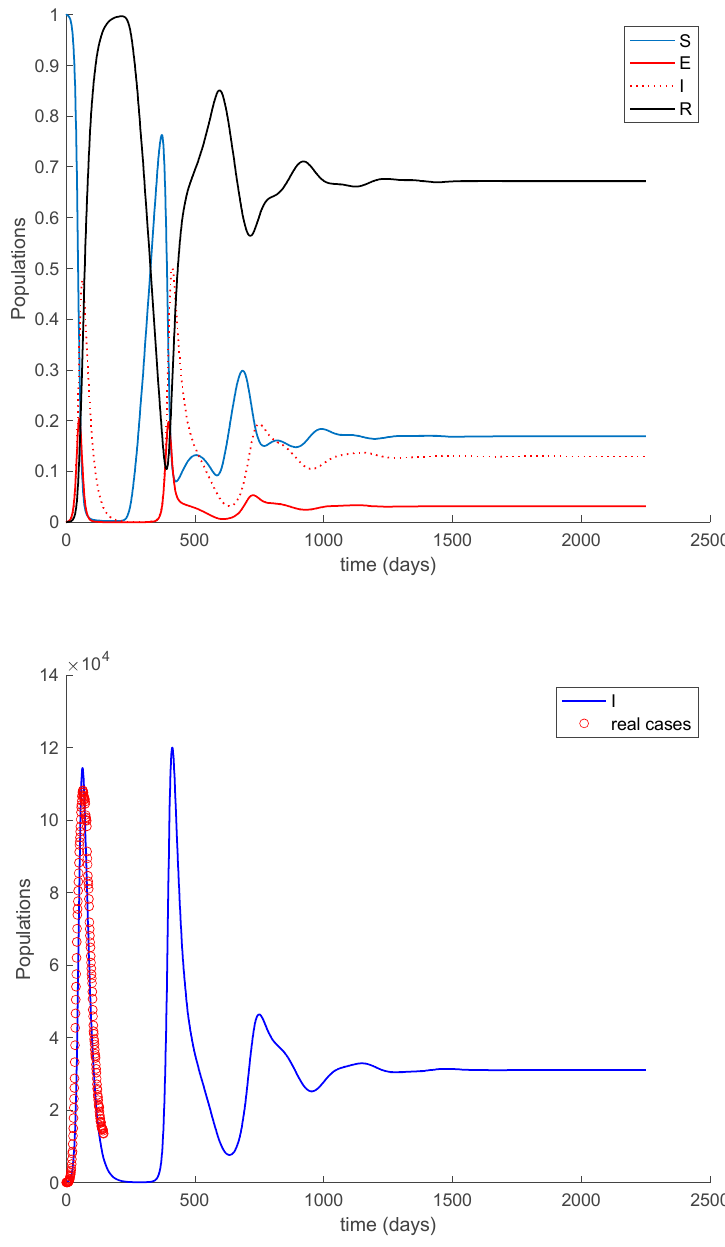
Figure 17. Dynamics of the model for the COVID-19 pandemic in Italy for Case 2.3. There is no vaccination, and there is a constant loss of immunity with delay.